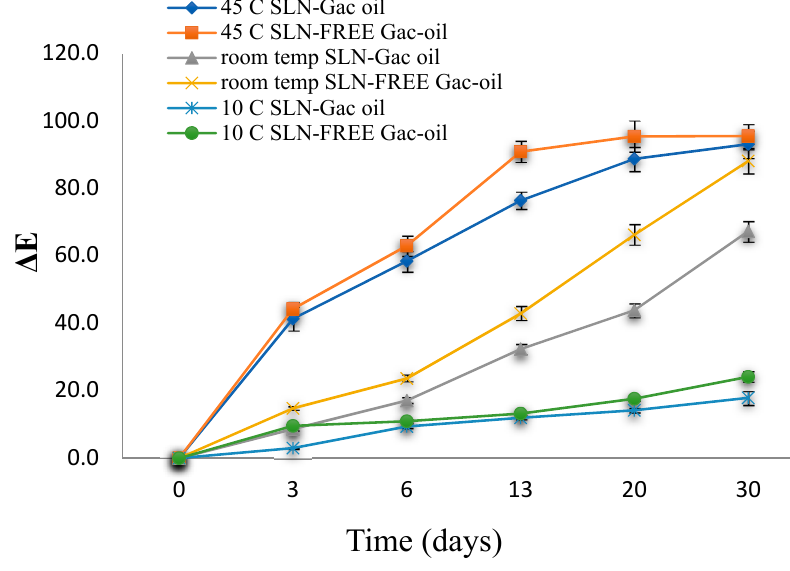
Figure 10. Effects of different temperatures on Δ E values of samples.